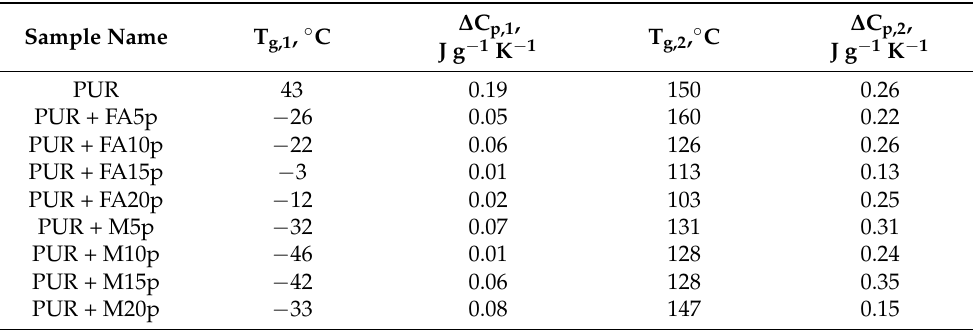
Table 6. Glass transition temperatures and changes in heat capacity, calculated from DSC curves, for the PUR